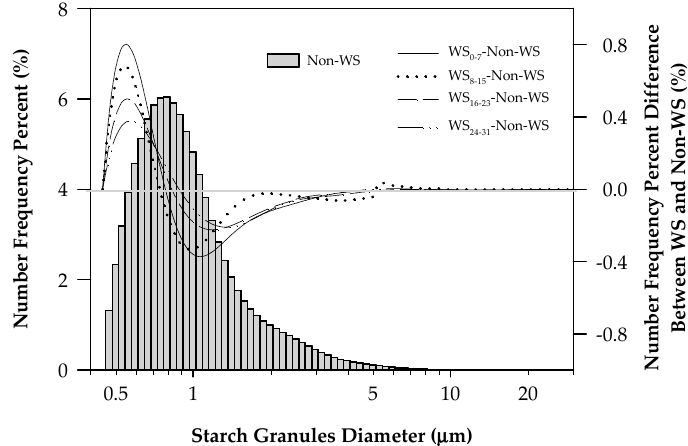
Figure 3. Effects of post-anthesis combined waterlogging and shading stress on starch granule number distribution profile in the endosperm of mature wheat grains. WS–Non-WS indicates the difference of the number frequency percent distribution profile of the starch granules between WS and Non-WS.